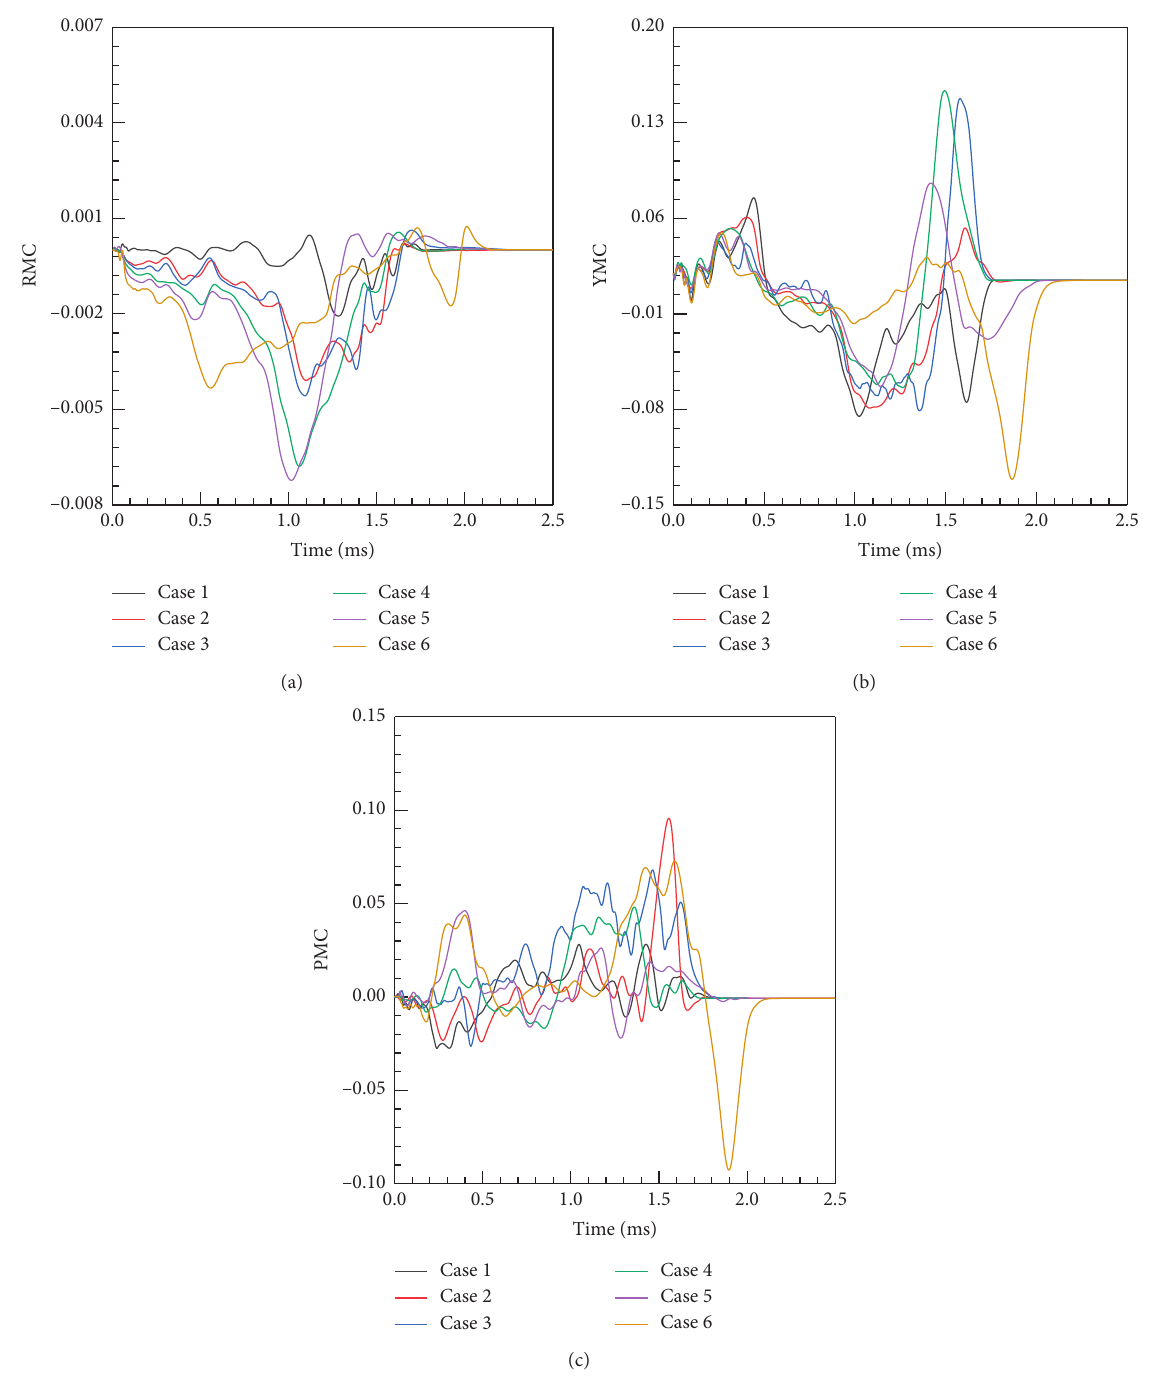
Figure 15: Moment coefficient: (a) RMC, (b) YMC, and (c)